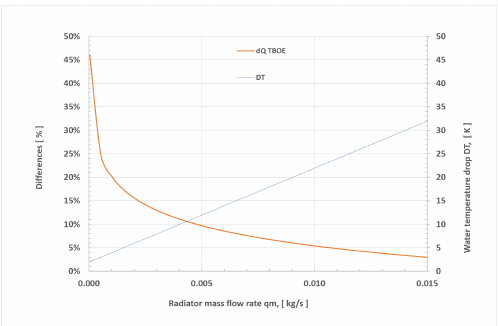
Figure 1. The discrepancy between the actual radiator power heat output and calculated according to the equation for the TBOE